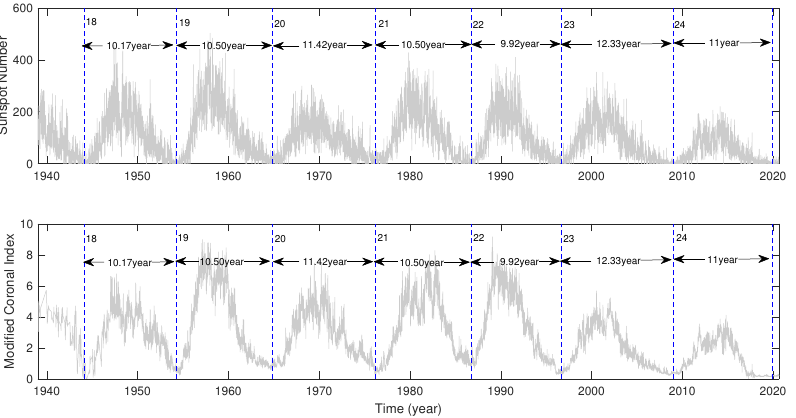
Figure 4. Observed data of the sunspot numbers and the modified coronal index in normal solar cycles 18–24; Upper panel: sunspot numbers; Lower panel: modified coronal